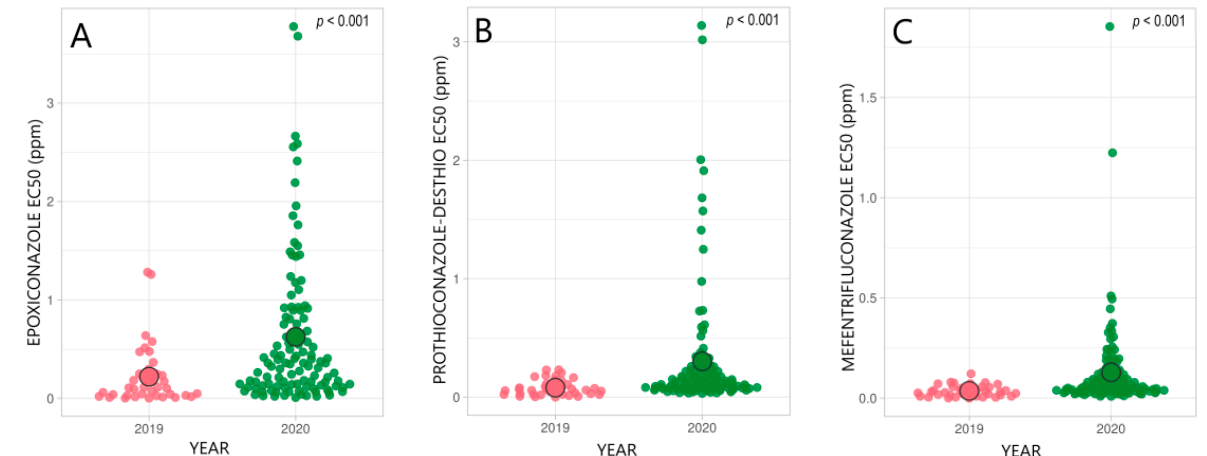
Figure 2. Distribution of the azole sensitivity of the R. collo-cygni population in 2019 and 2020 in Estonia. Epoxiconazole ( A ); prothioconazole-desthio ( B ), and mefentrifluconazole ( C ) were tested. ○ indicates the average EC 50 value (ppm) in a population; p < 0.001 shows a significant difference between the years [20].